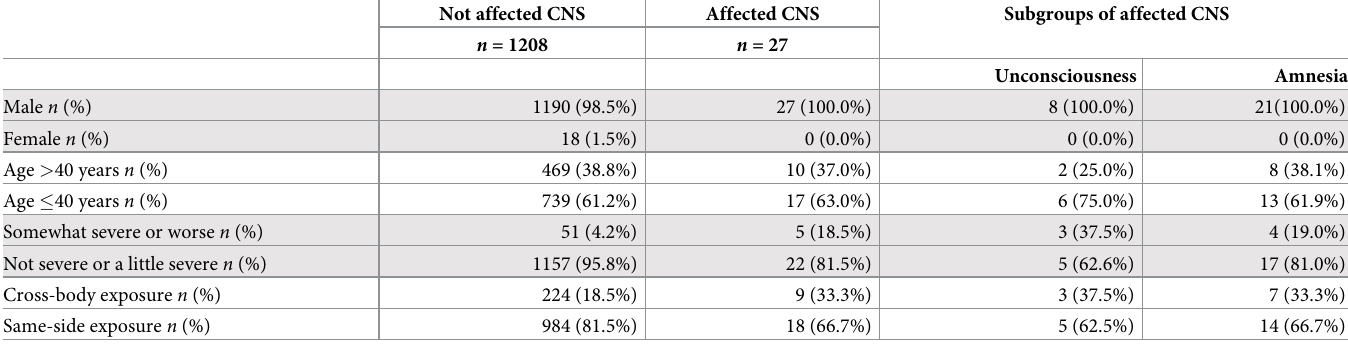
Table 1. Demographics and cross-body exposure to electrical current in relation to unconsciousness and amnesia in connection with electrical shock reported by Danish electricians ( n = 1235).